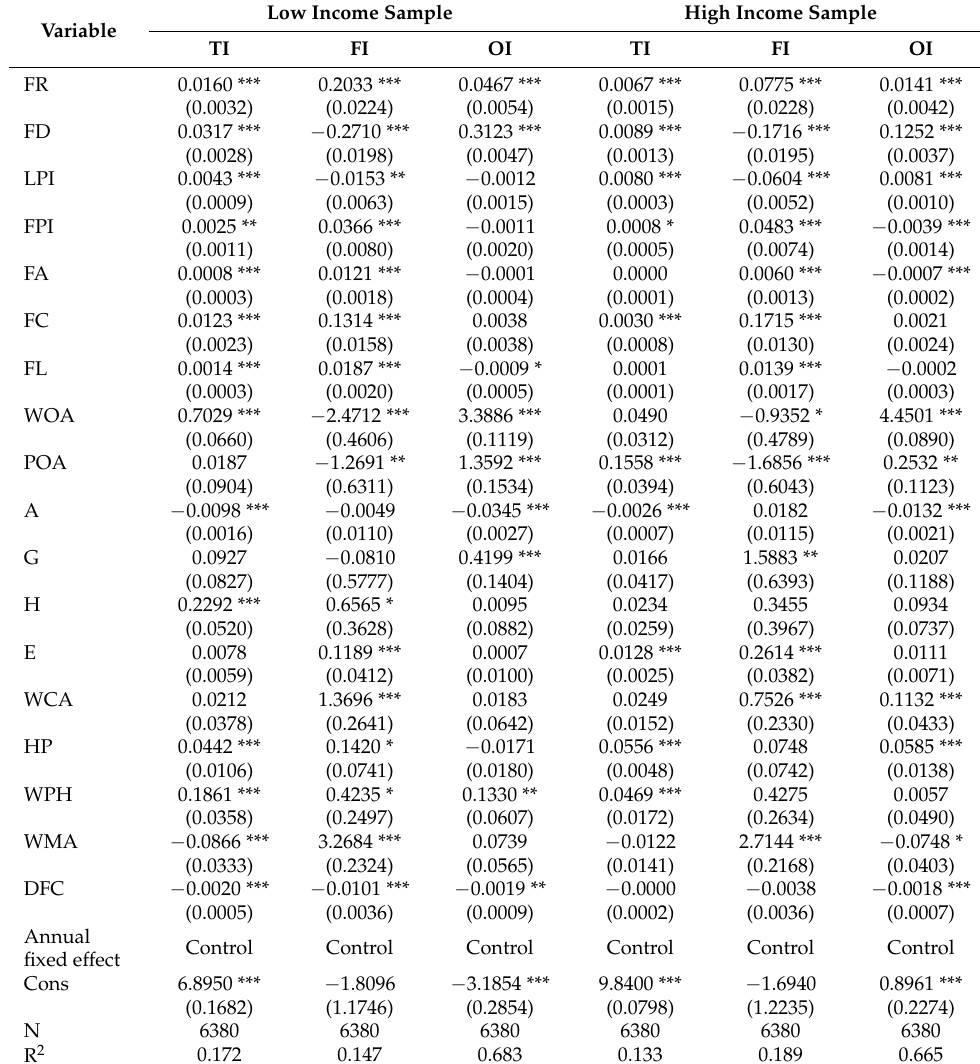
Table A1. Income-increasing the effect of collective forestland tenure reform on households with different incomes—sub-sample regression.